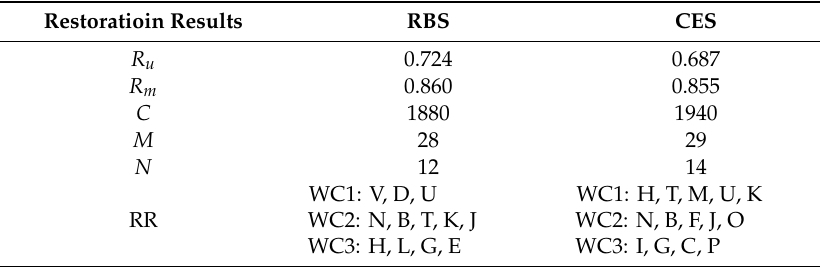
Table 5. Restoration results (RR) of the RBS and CES.